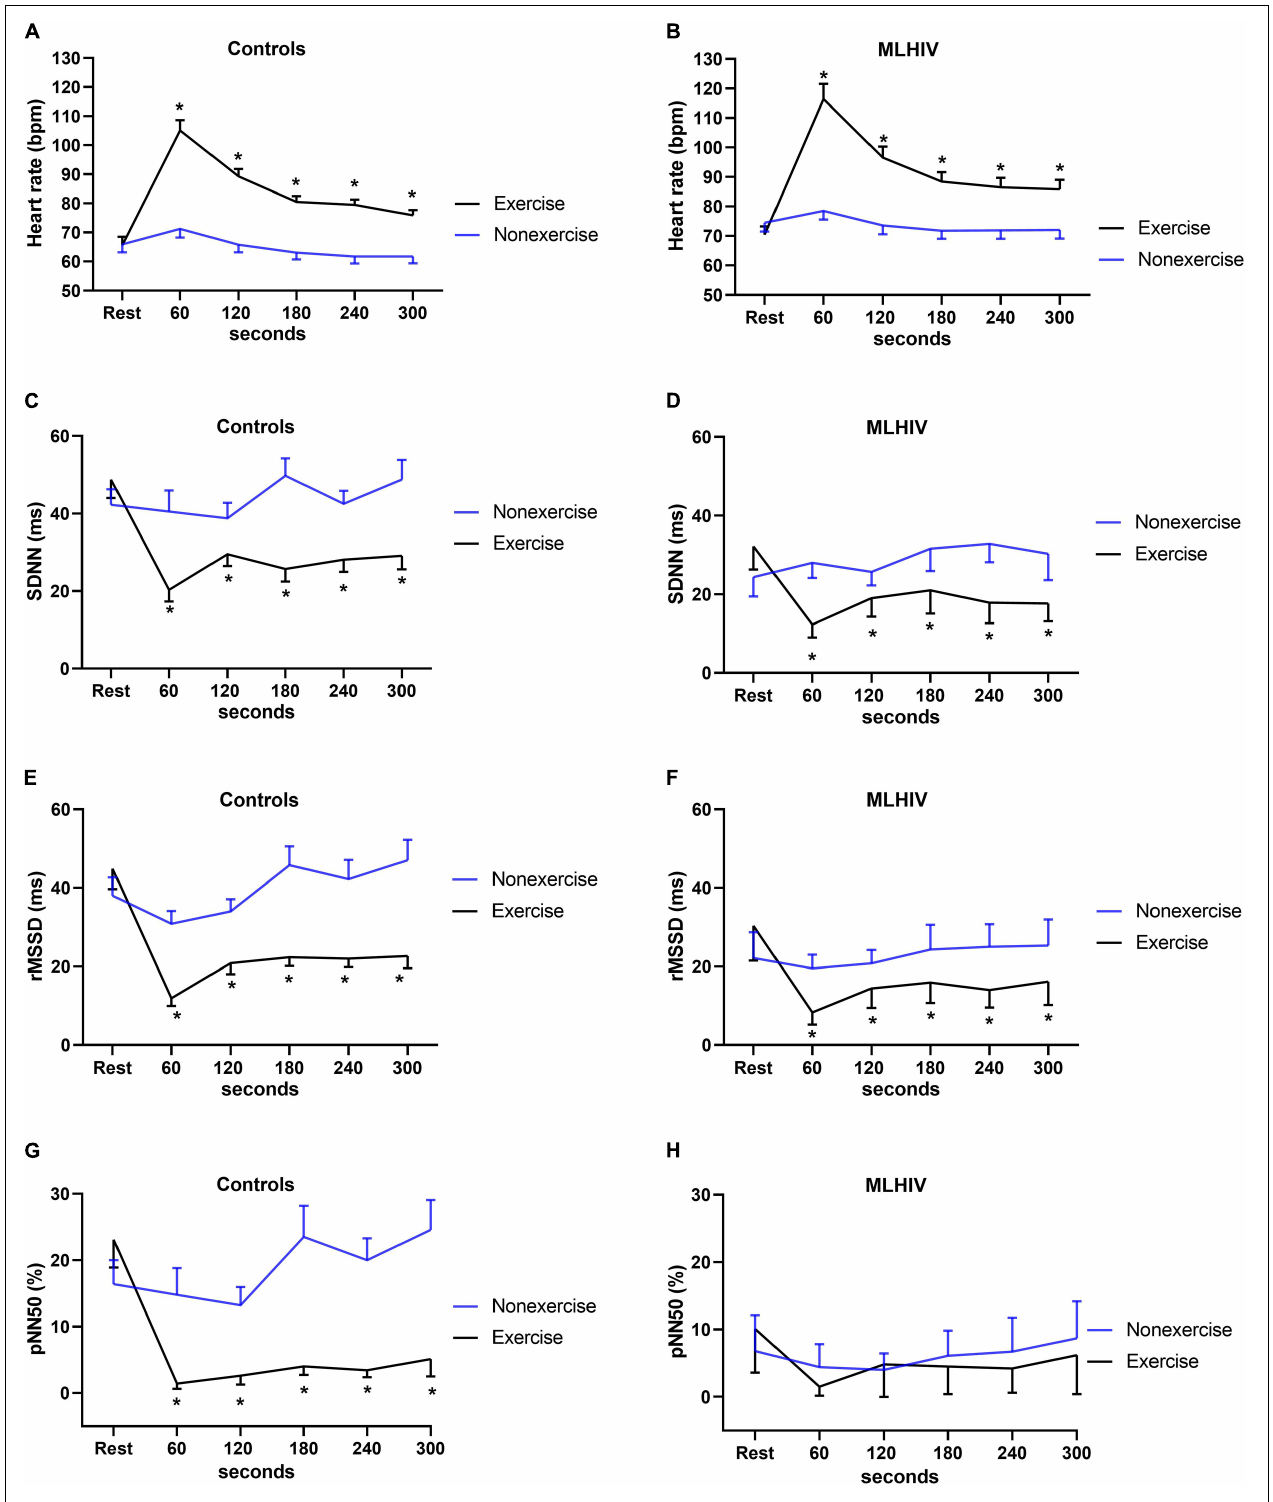
FIGURE 4 | Heart rate (A,B) and heart rate variability indices (C–H) from baseline to 5 min after exercise or non-exercise sessions in controls and men living with HIV (MLHIV). SDNN, standard deviation of normal to normal intervals; rMSSD, root mean square of successive differences between normal intervals; pNN50, percentage of differences between adjacent normal intervals. * p < 0.05 for changes from baseline (exercise vs. non-exercise session) using linear mixed models.